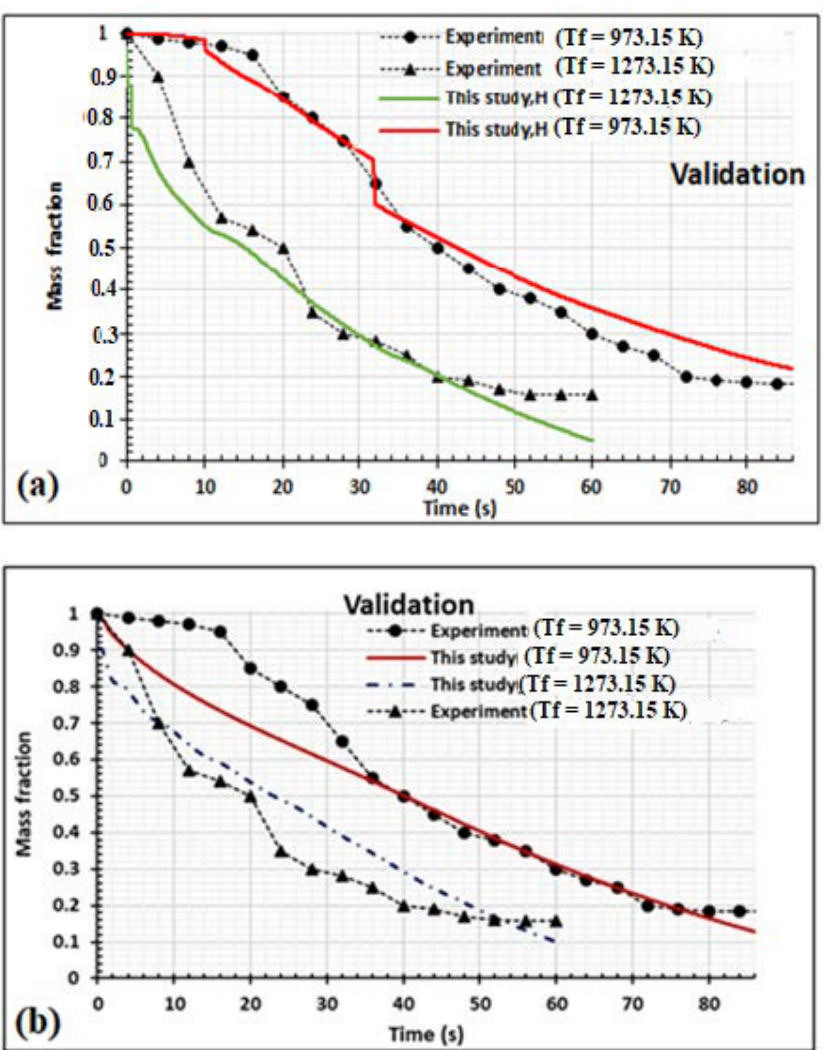
Figure 4. Mass validation of the model using experimental data taken from Bonnefoy et al. [38] at Tf = 973.15 K and Tf = 1273.15 K for 10 mm thick cubic samples, ρ bo = 700 kg/m 3 : ( a ) moisture content in the wood sample is taken into account; ( b ) moisture content in the wood is not taken into